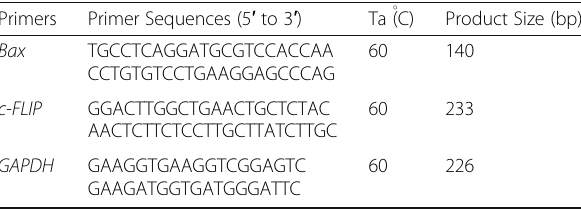
Table 1 Sequence of primers for